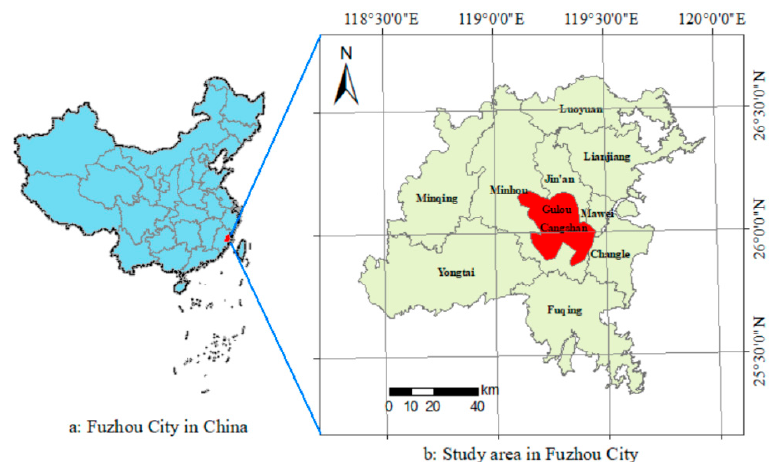
Figure 1. Location of the study